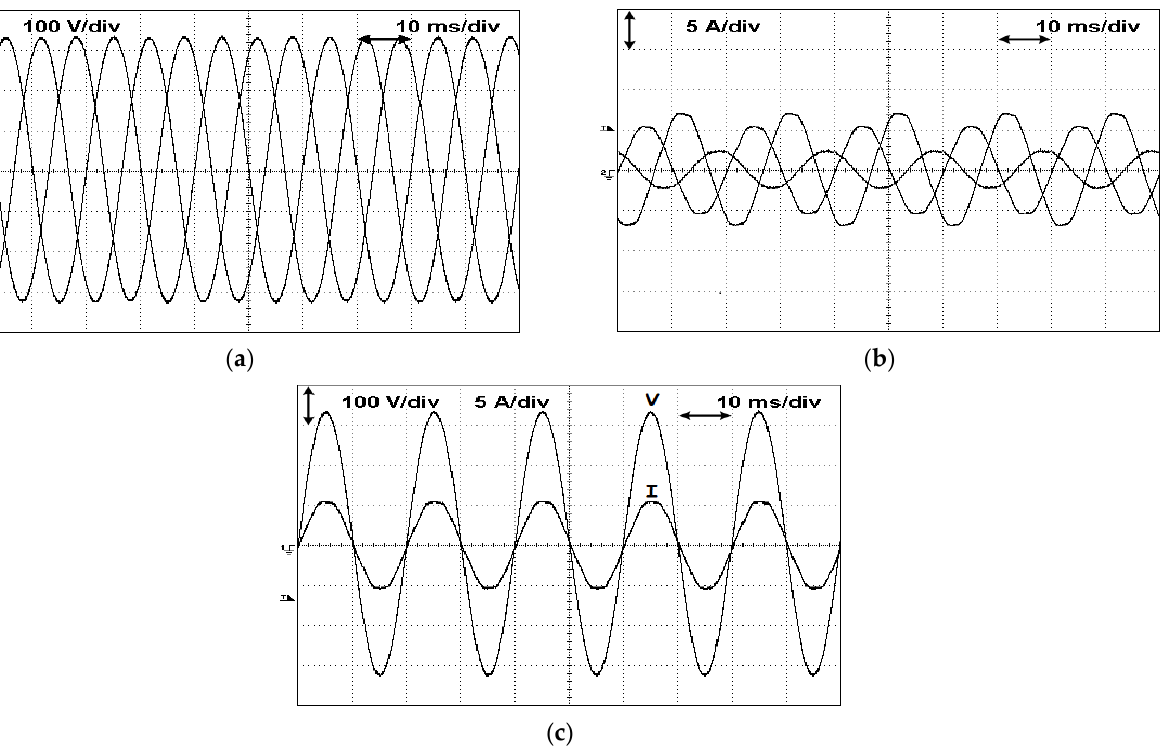
Figure 14. Waveforms obtained from the test using the PV inverter with four legs for an imbalanced condition and without reactive compensation: ( a ) three-phase voltages imposed by the testing system, ( b ) three-phase currents injected by the PV system, ( c ) voltage and current in phase L 1 of the testing system.